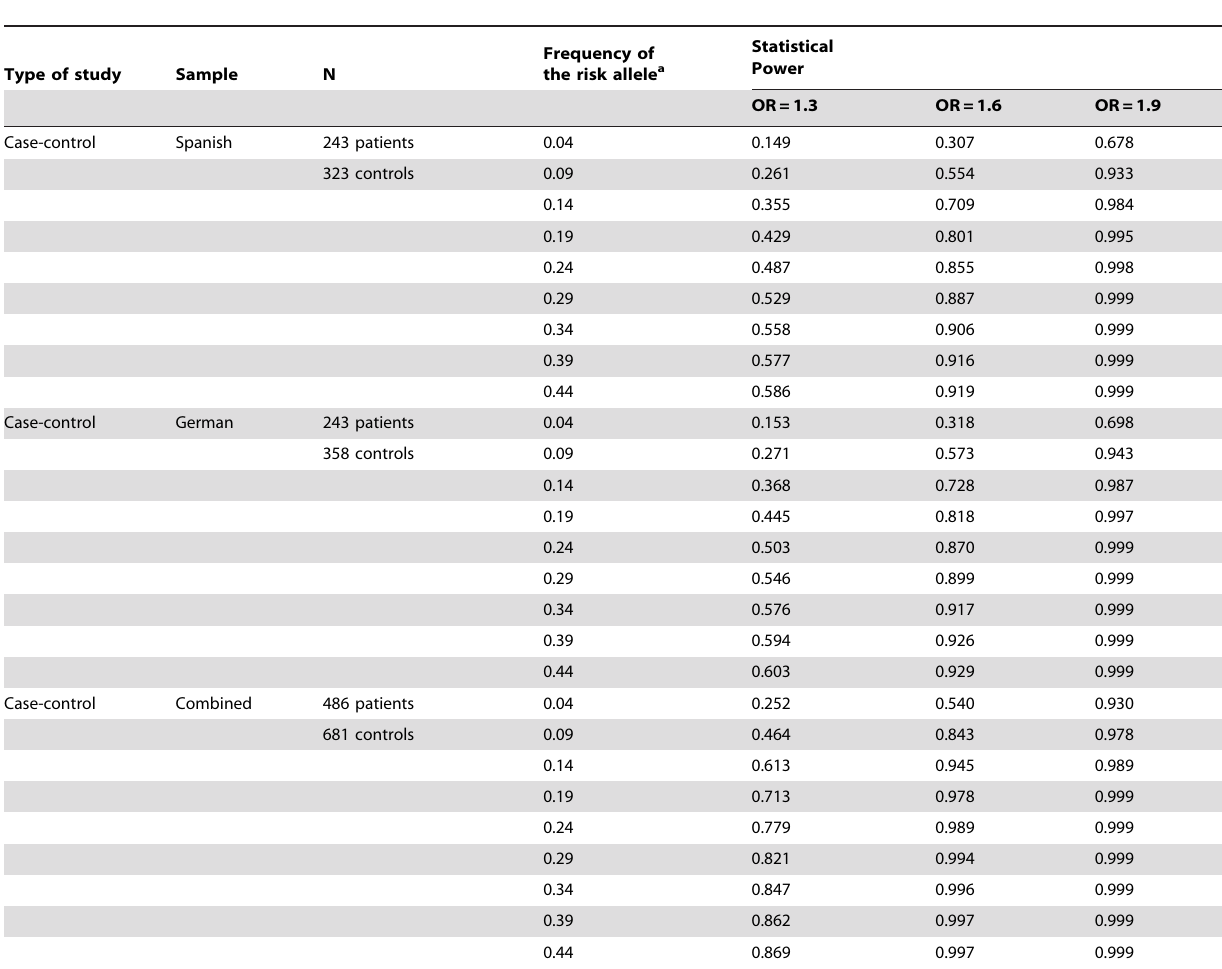
Table 4. Estimation of the statistical power associated to the different case-control and family-based studies.